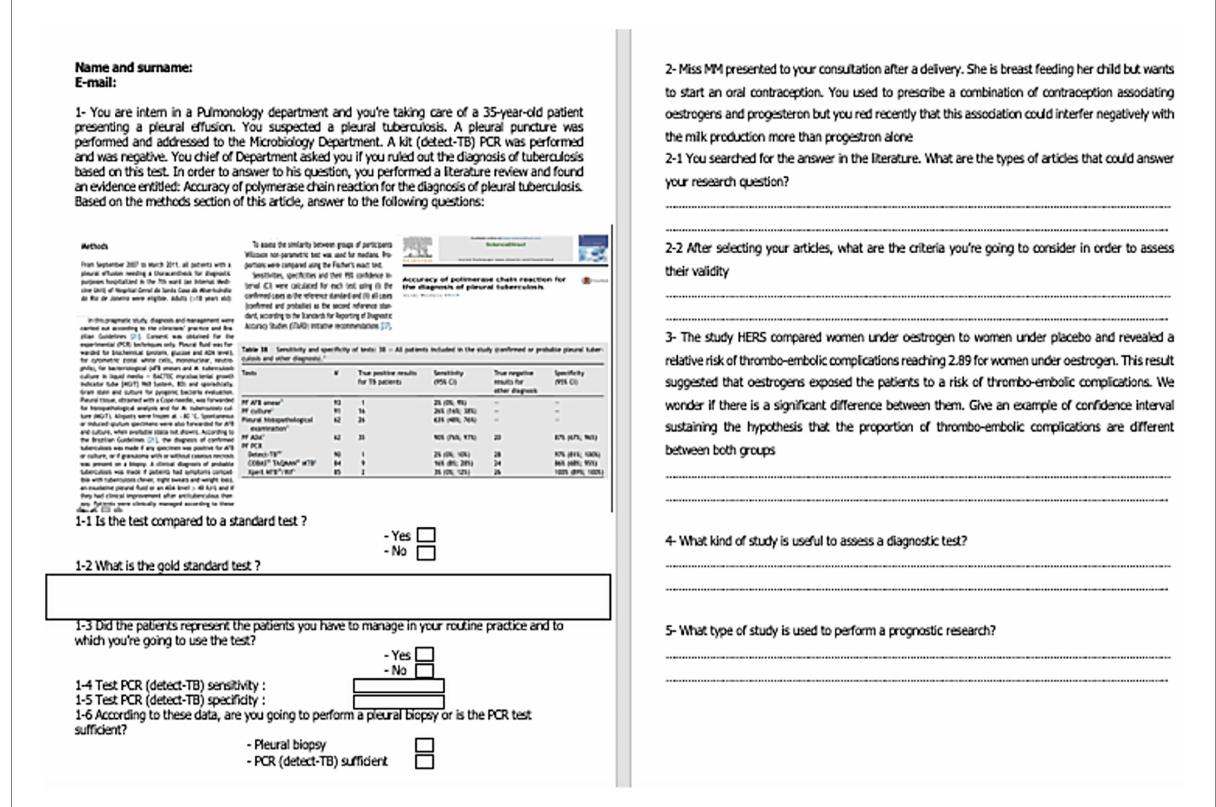
FIGURE 1 The final test adopted from the Fresno test.